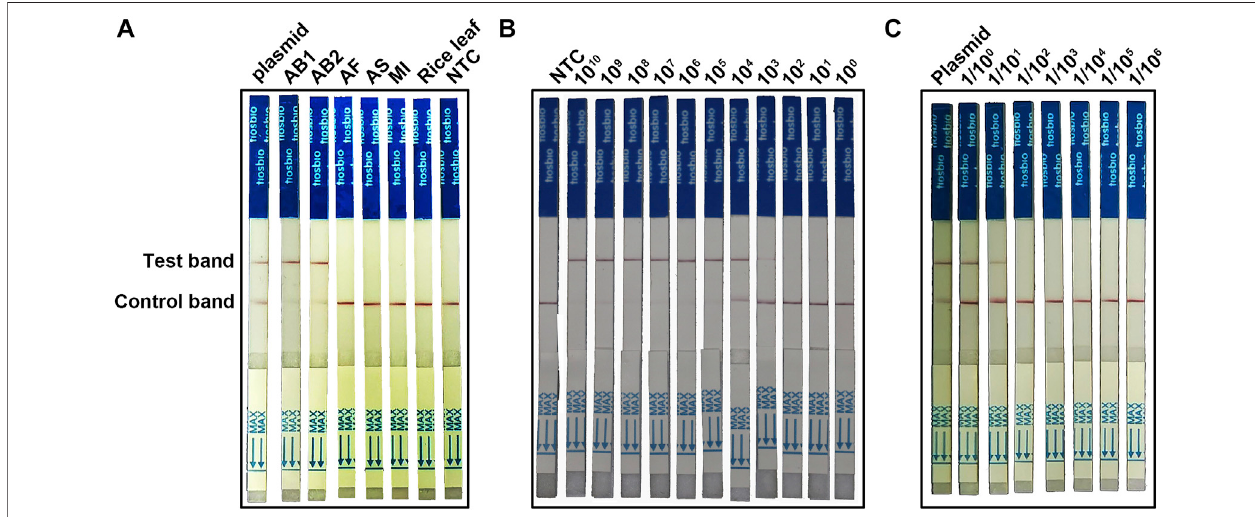
FIGURE 6 | Establishing the RPA-Cas12a-Ab LFA assay. (A) Evaluation of the speci fi city of the RPA-Cas12a-Ab LFA assay. (B) Evaluation of the sensitivity of the RPA-Cas12a-AbLFAassayusingaserial10-folddilution(10 10 − 0 copies/ μ l)ofthepUC57-18Splasmid. (C) SensitivityevaluationoftheRPA-Cas12a-AbLFAassayusing a serial 10-fold dilution (1/10 0 − 6 ) of single A. besseyi nematode gDNA. The initial gDNA of a single A. besseyi is about 9.6 ng/ μ l. Plasmid pUC57-18S is used as the positivecontrol;AB1, Aphelenchoidesbesseyi-1 ;AB2, Aphelenchoidesbesseyi-2 ;AS, Aphelenchoidessubtenuis ;AF, Aphelenchoidesfragariae .MI, Meloidogyne incognita ; NTC, no template